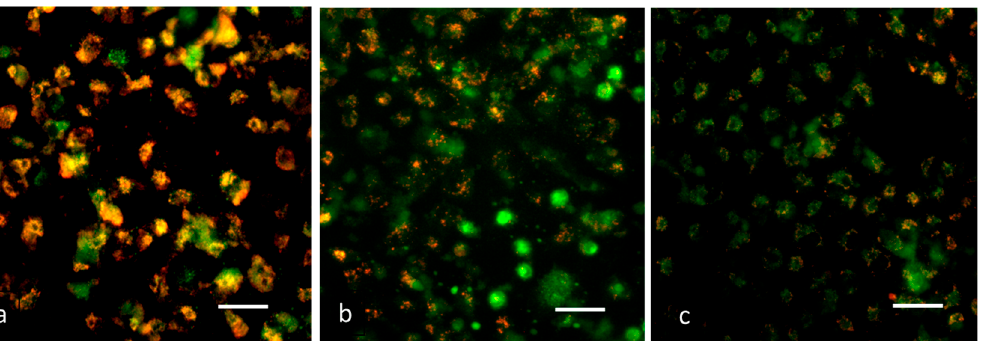
Figure 7. MDA-MB-231 cells with MgO-Chitosan-Pluronic F127-Escin NPs present have decreased mitochondrial membrane permeability. MgO-Chitosan-Pluronic F127-Escin NPs were used to treat breast cancer MDA-MB-231 cell lines. JC-1 was used to stain the cells, and a representative stained cell was shown for each group. Control ( a ), 10 µg/mL of MgO-Chitosan-Pluronic F127-Escin NPs-treated cells ( b ), and 20 µg/mL of MgO-Chitosan-Pluronic F127-Escin NPs-treated cells ( c ). Red fluorescence indicates normal mitochondria, and green fluorescence indicates damaged mitochondria (scale bar 50 µm). 20X magnification was used to capture the images.